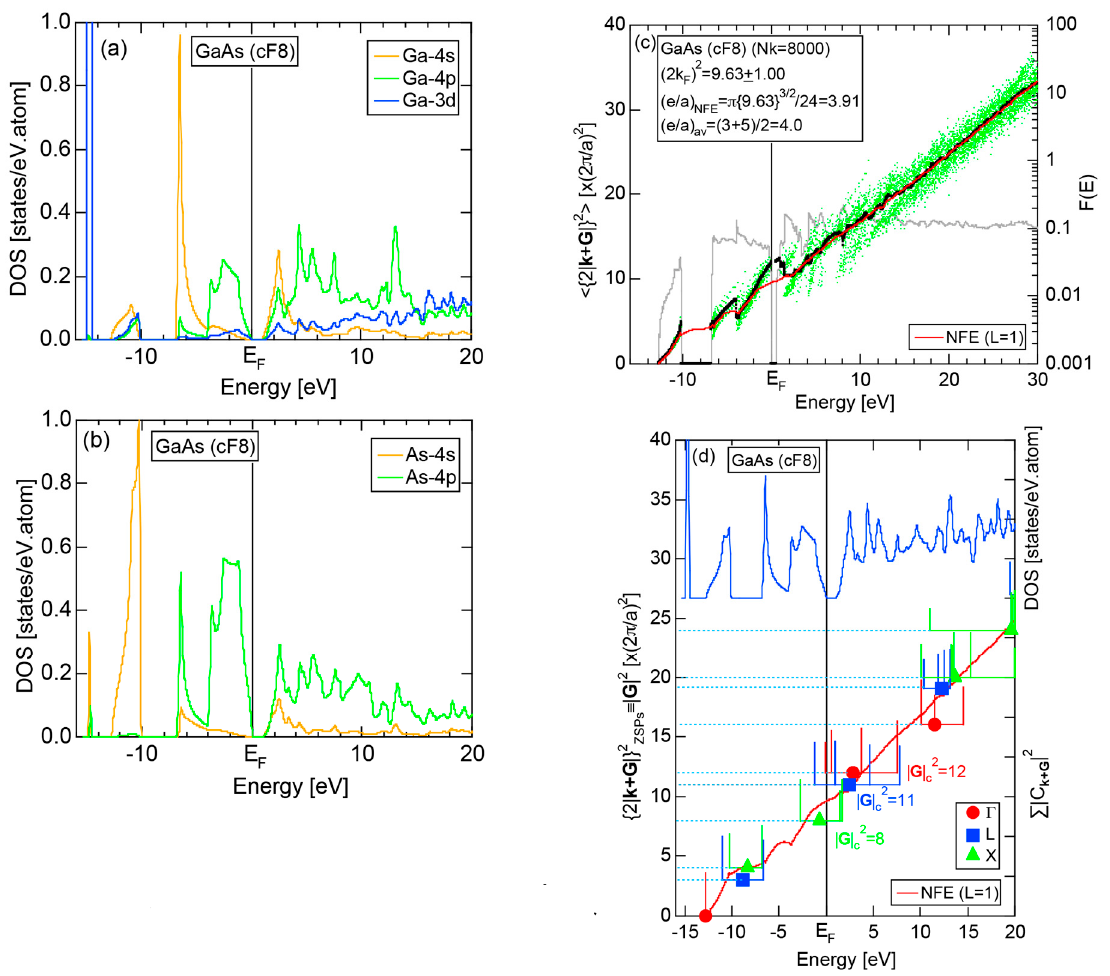
Figure 106. ( a ) Ga- and ( b ) As-pDOSs, ( c ) Hume-Rothery plot and ( d ) FLAPW-Fourier spectra at symmetry points Γ , L, and X of the fcc Brillouin zone along with the total DOS for GaAs (cF8). See captions to Figure 19 (b) for symbols in (c) [11].